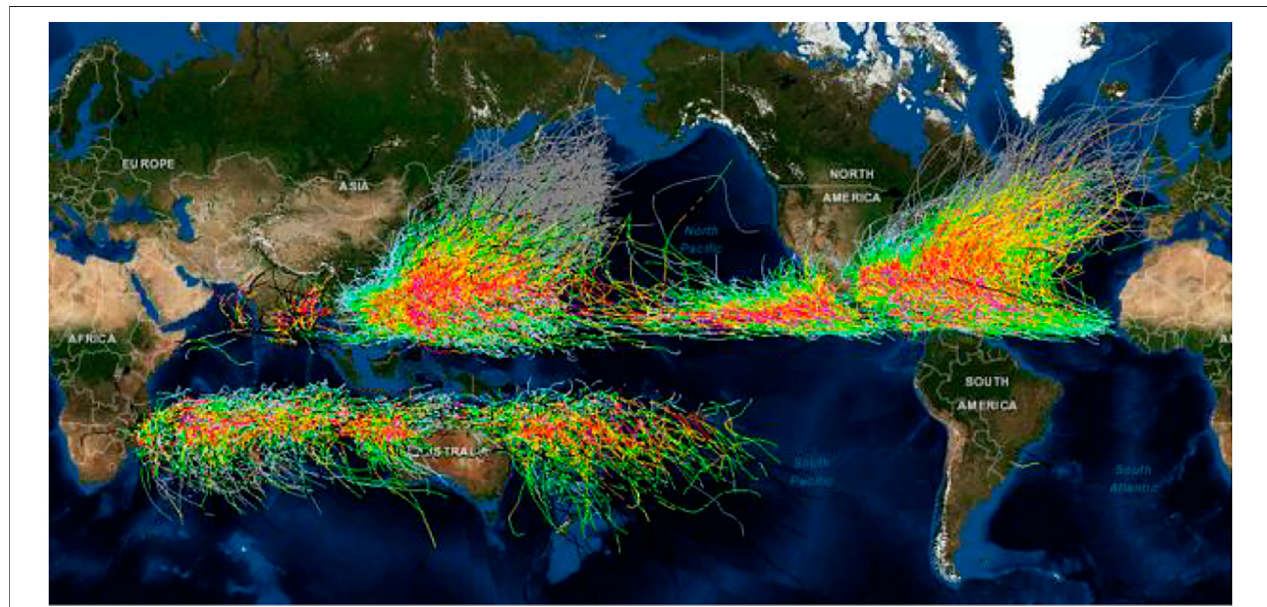
FIGURE 8 | Global tropical storm tracks 1848 – 2013. Red and orange, Saf fi r-Simpson category 4 and 5, yellow and green category 1-3, blue tropical storms, and depressions. Source NOAA Digital GeoZone.